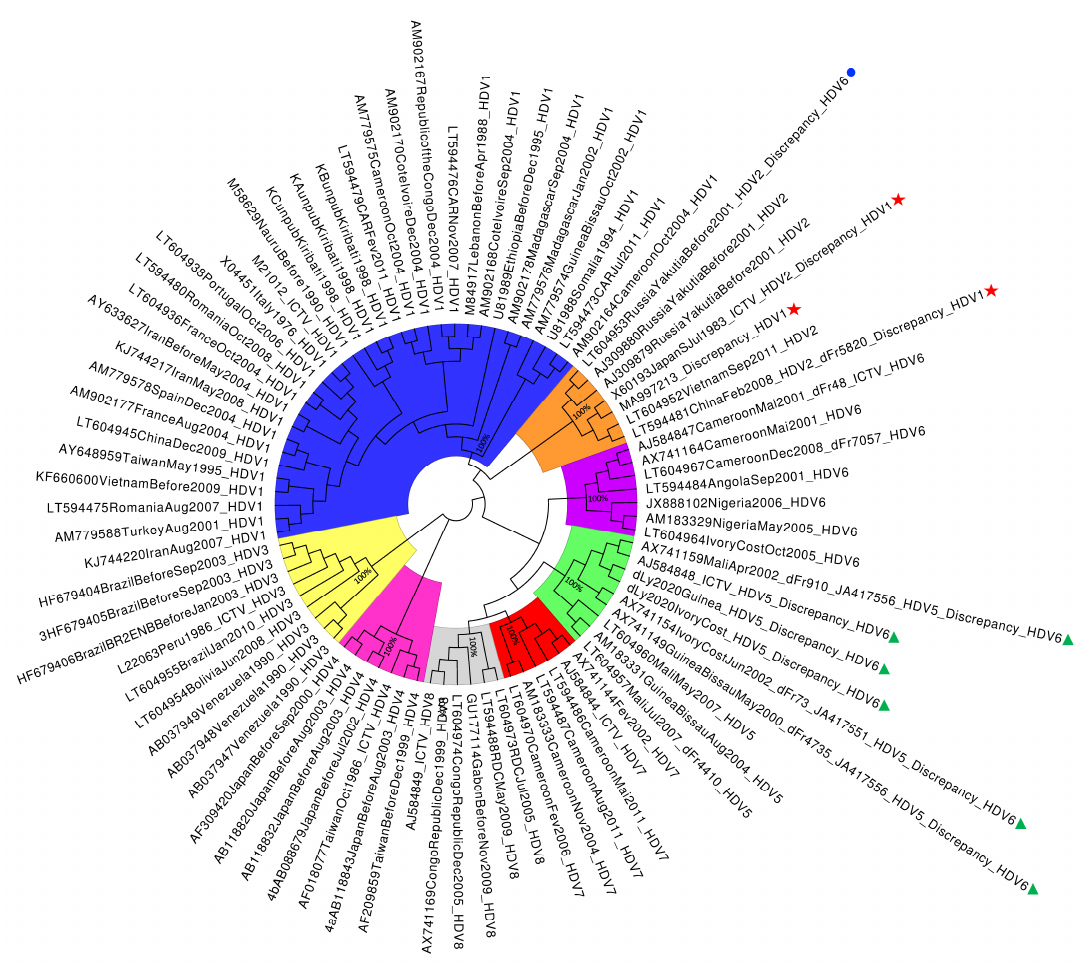
Figure 2. Phylogenetic tree computed with MEGA7 and represented upon a cladogram type using Figtree v1.4.4. The percentage of replicate trees in which the associated taxa clustered together in the bootstrap test (1000 replicates) are shown next to the main genotype branches. The analysis involved 84 complete genome sequences. All positions containing gaps and missing data were eliminated. There were a total of 1247 positions in the final dataset. HDV-1 is represented in blue, HDV-2 in orange, HDV-3 in yellow, HDV-4 in pink, HDV-5 in green, HDV-6 in purple, HDV-7 in red, HDV-8 in grey. Green triangles highlight HDV-5 sequences genotyped as HDV-6 by HDVdb genotyping tool. Red stars highlight HDV-2 sequences genotyped as HDV-1. Blue circle highlights HDV-2 sequence genotyped as